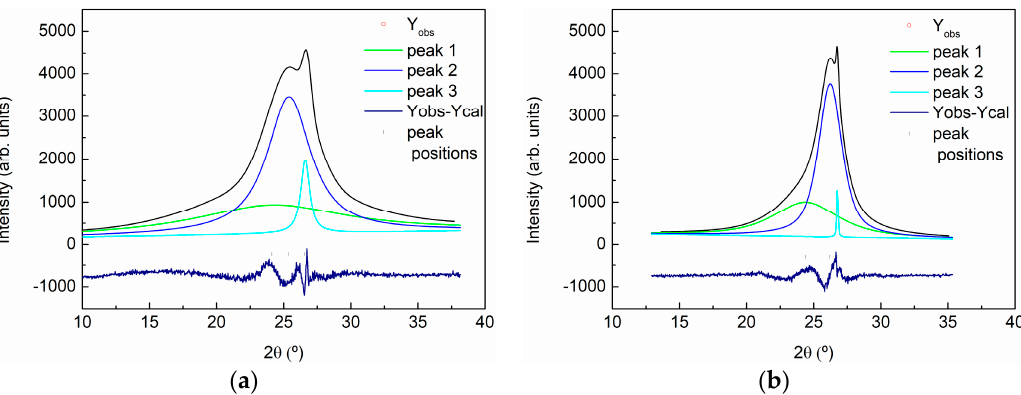
Figure 6. X-ray diffraction pattern of GO and rGO. Deconvolution of 10–40° 2 θ range of the pattern of GO ( a ) and rGO ( b ). Table 3. Measured interplanar spacings converted to lattice constants, dispersion, and semi-quantitative analysis for GO and rGO.